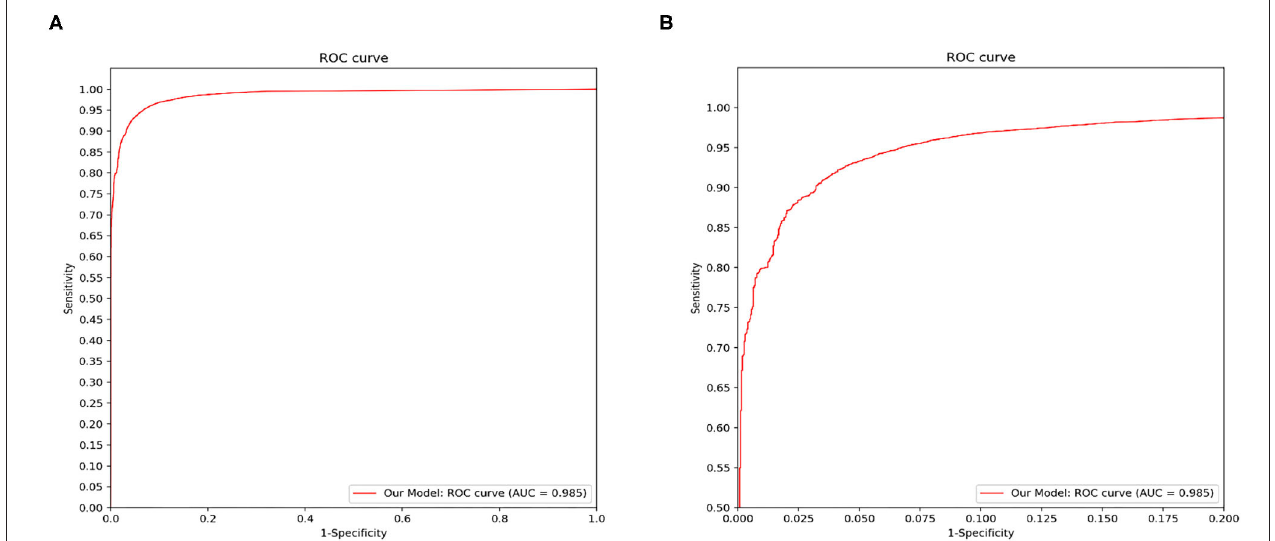
FIGURE 5 | Disease classification performance of the proposed model. We fix a threshold probability t such that the prediction y for any image is y = P ≥ t, and the curve is drawn by sweeping t in the interval 0–1. The AUC is the CNN’s measure of performance, with a maximum value of 1. Our model achieves 0.985 AUC in 14-way classification. (A) The full view of the ROC curve of the proposed model. (B) The local enlarged image of the ROC curve between abscissa 0 ∼ 0.2.